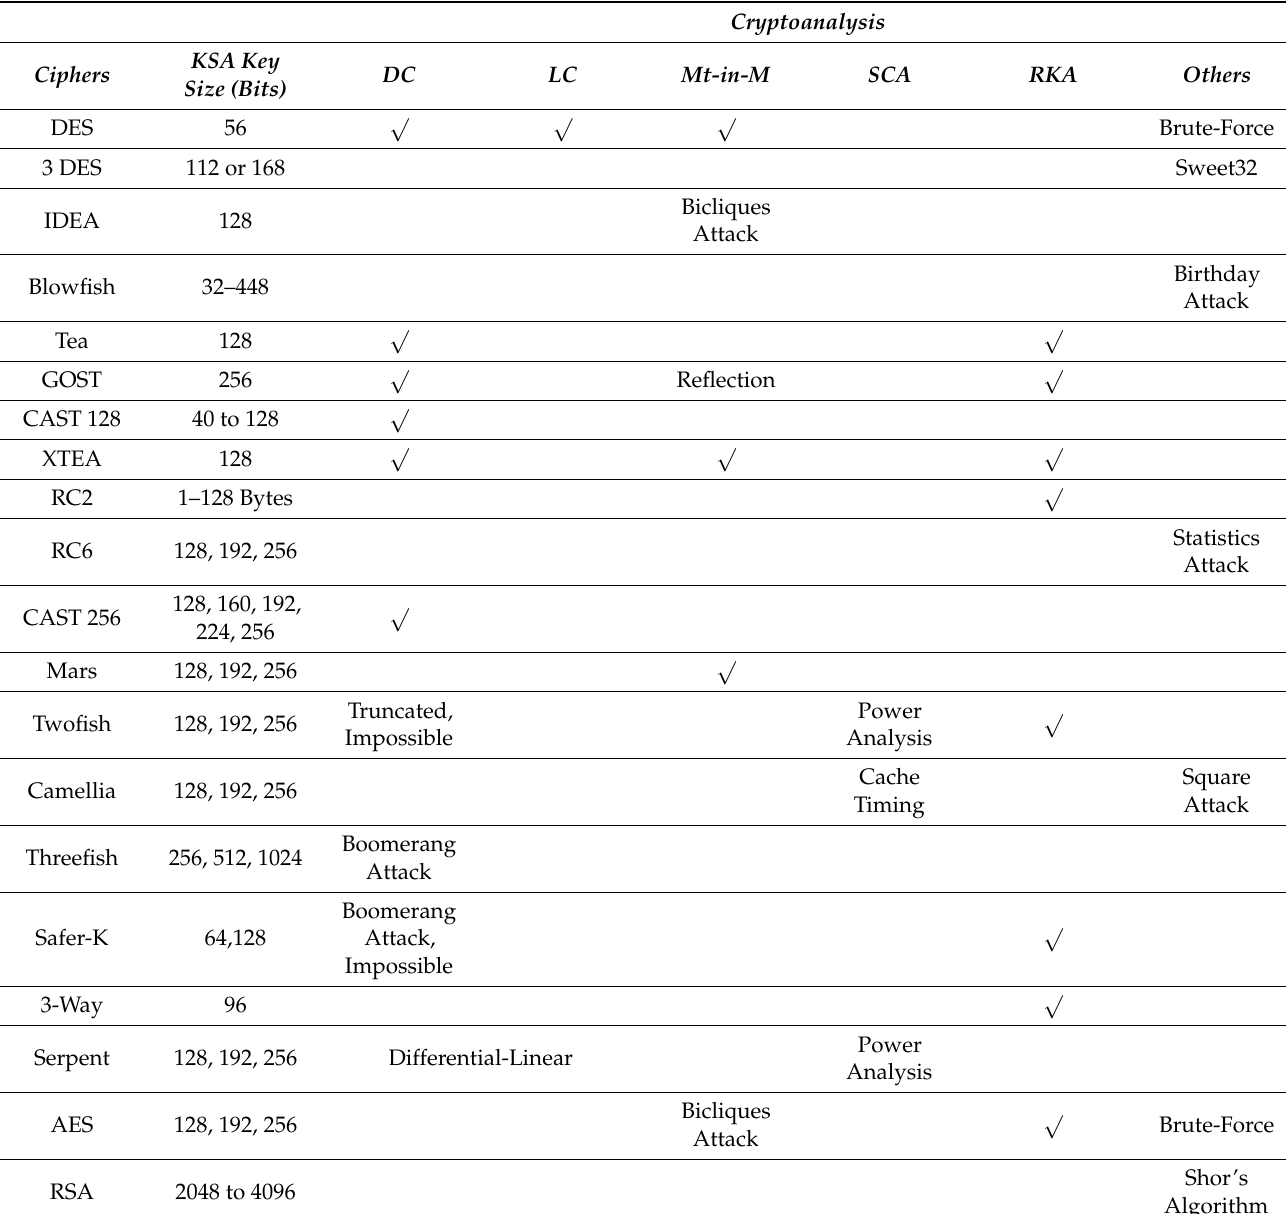
Table 3. Cryptanalysis of cryptography